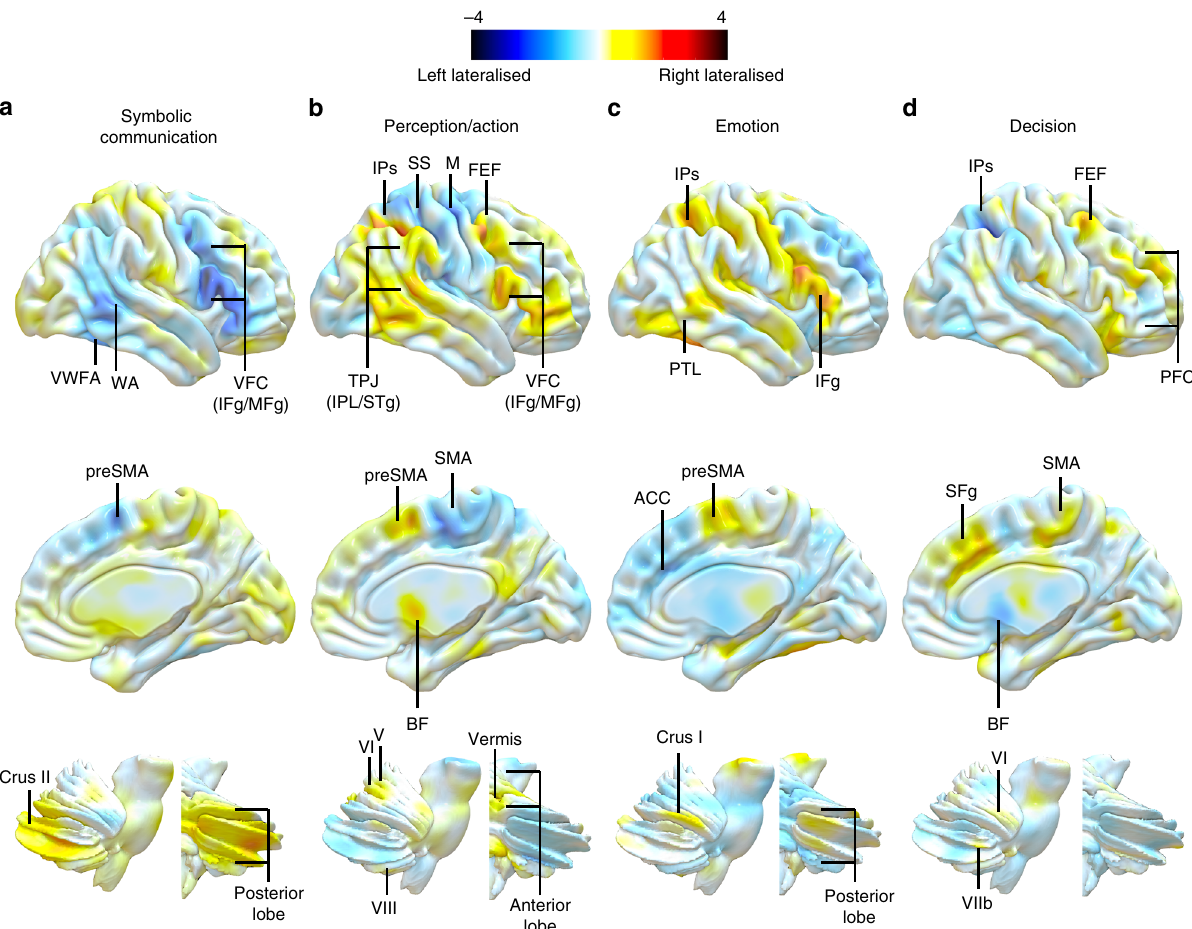
Fig. 2 Archetypes of functional lateralisation. The maps correspond to the symbolic communication ( a ), perception/action ( b ), emotion ( c ) and decision ( d ) axes. Upper panel corresponds to the lateral view, middle panel to the medial view and lower panel to the cerebellum view (lateral and posterior views) of the reconstructed pattern of activations. VWFA visual word form area, WA Wernicke area, VFC ventral frontal cortex, IFg inferior frontal gyrus, MFg middle frontal gyrus, TPJ temporo-parietal junction, IPL inferior parietal lobule, STg superior temporal gyrus, IPs intraparietal sulcus, SS somatosensory cortex, M motor cortex, FEF frontal eye fi eld, PTL posterior temporal lobe, PFC prefrontal cortex, SMA supplementary motor area, preSMA presupplementary motor area, ACC anterior cingulate cortex, BF basal forebrain (maps are available as Supplementary Data 2 –